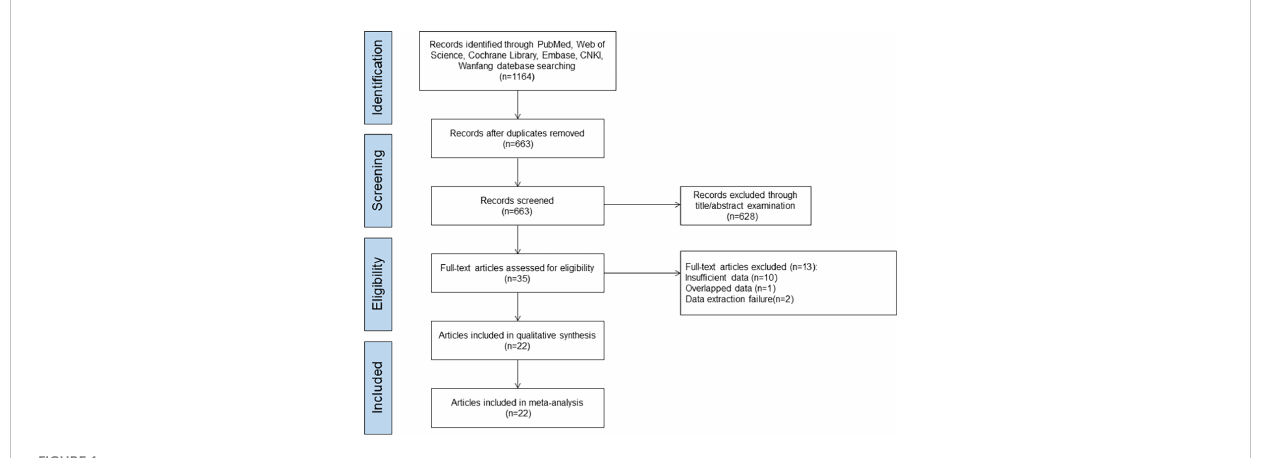
FIGURE 1 Literature screening fl